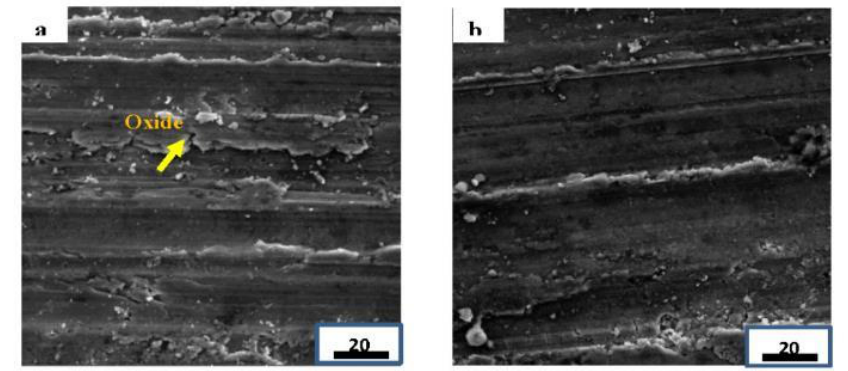
Fig. 13. SEM of the abrasive grooves. (a) Coarse abrasive grooves in Al 7075 3 wt.% TiC, (b) Shallow grooves with TiC particles in Al 7075 9wt.% TiC at 30 N load condition.